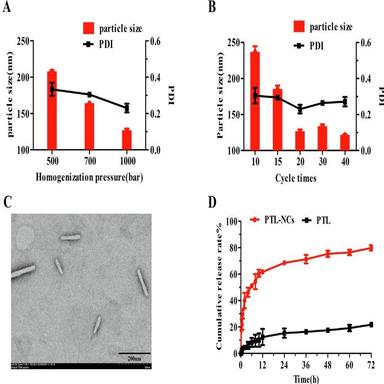
The influence of (A) the pressure and (B) the cycle times of homogenization on particle size and PDI of the PTL-NCs. (C) The TEM images of the PTL-NCs. (D) The PTL release profile of PTL-NCs in PBS (pH = 7.4) at 37 °C. Data are presented as mean ± SD (n = 3).